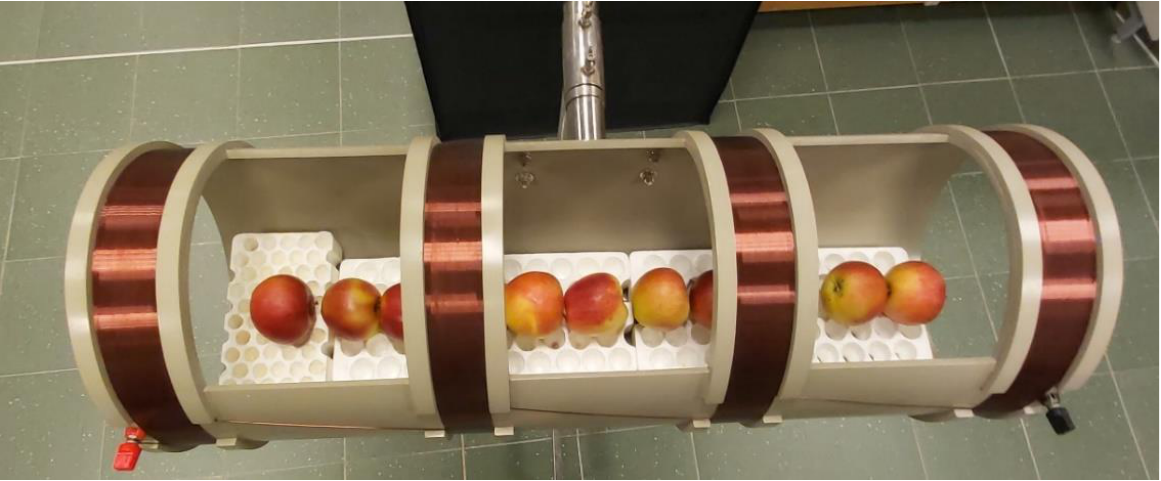
Figure 1. Coil designed for fruit storage in room conditions. The quality parameters of the MF and control groups were evaluated after cold storage and after 14 days of storage in room